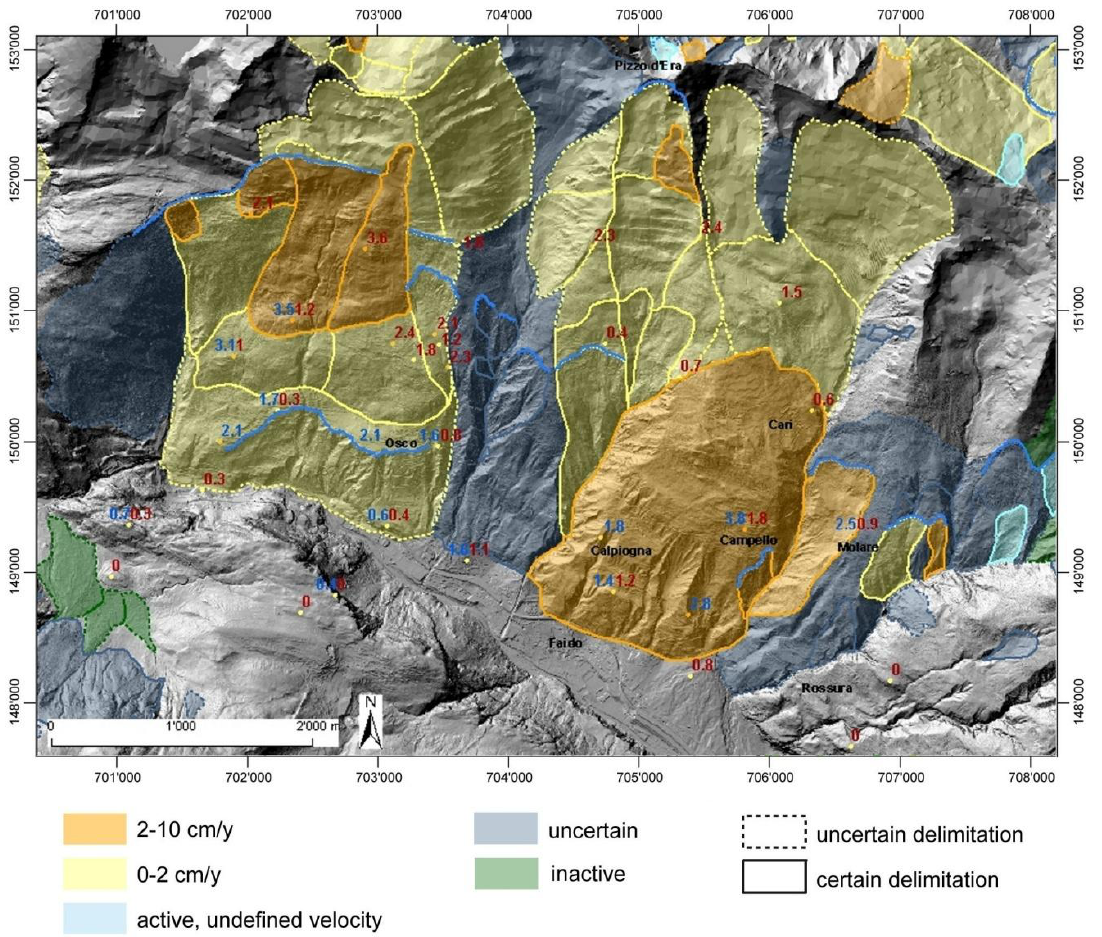
Figure 7. Inventory of the deep-seated landslide in Osco. Image background is a shaded relief of DHM25 (© Swisstopo). Legend according to [40]. Blue lines indicate major scarps. Blue numbers indicate the 3-dimensional displacement rates in cm/yr from geodetic monitoring for the period 1994–2000, while red numbers indicate the displacement rates in cm/yr from geodetic monitoring for the period